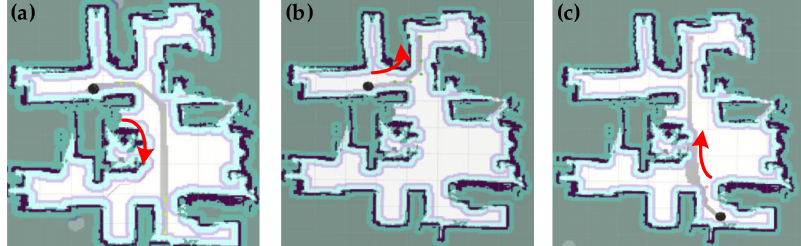
Figure 11. Heuristic search direction of A* is approximately optimal in the specific scenarios. ( a ) bed in master room to sink. ( b ) bed in master room to refrigerator. ( c ) refrigerator to